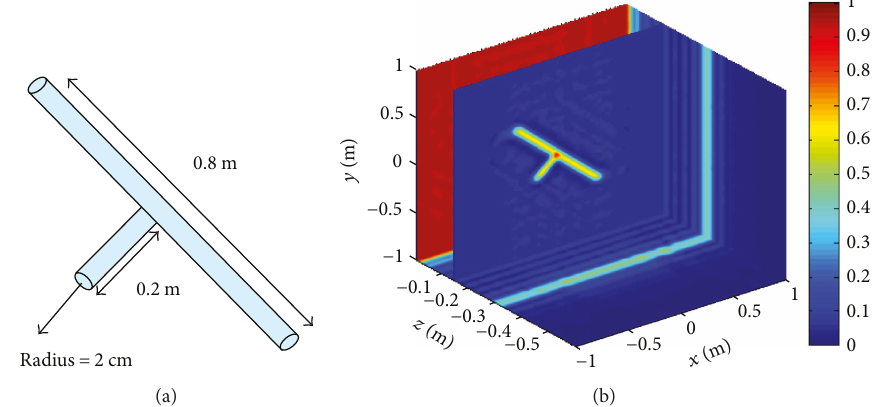
Figure 7: 3-D imaging of the tubes hidden inside the wall. (a) Dimension of tubes and (b) 3-D imaging